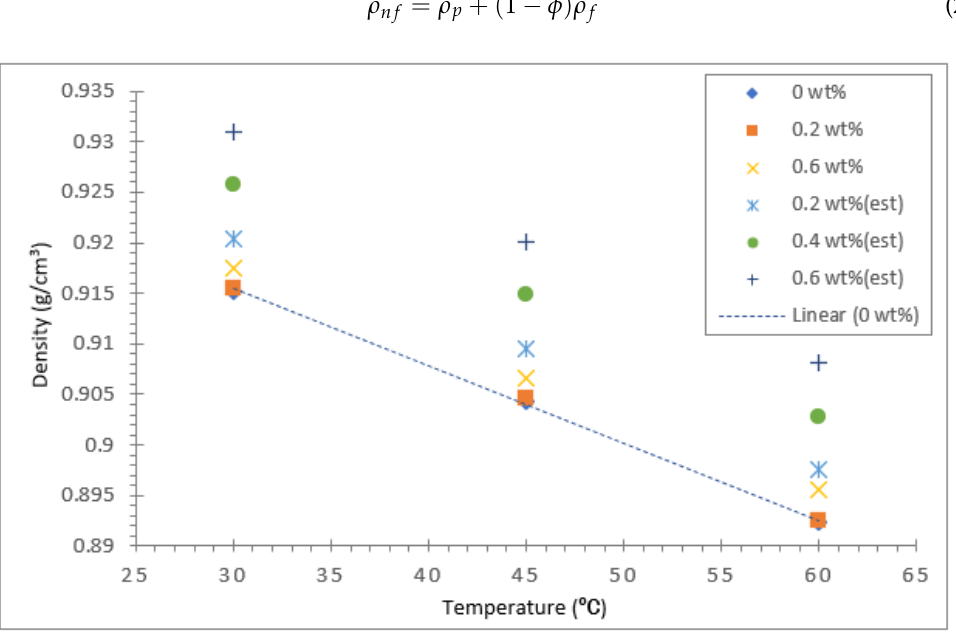
Figure 15. Density of coconut oil/Al 2 O 3 -TiO 2 hybrid nanofluid.